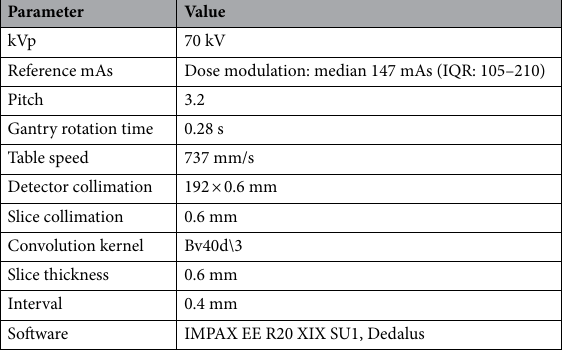
Table 2. Dual source computed tomography scan parameters for pediatric congenital heart disease patients. kVp Kilovolt peak, mAs Milliampere seconds, IQR Interquartile